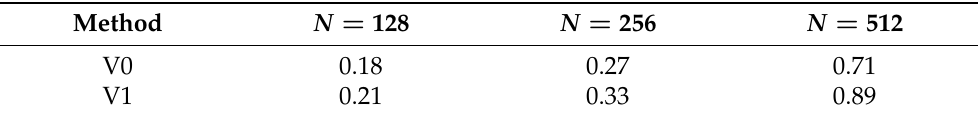
Table 3. Helmholtz 2D. CPU times (in seconds) for various number of quadrature points and representations. Times account for computing the solution for N × 12 grid points (for (cid:96) = 10 − k , k = 0,11 ) on a body-fitted (cid:74) (cid:75)